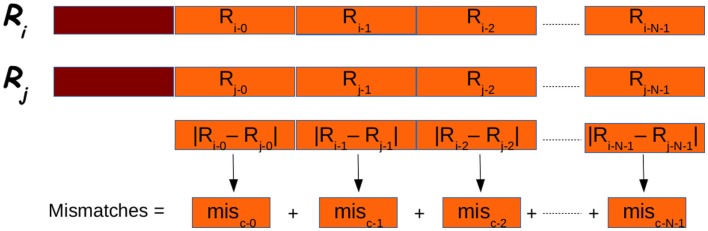
Suffixes (in orange in the figure) are analyzed in chunks. Each chunk is subject to the dual encoding used for prefixes (in red in the figure). The overall number of mismatches if obtained summing the partial number of mismatches obtained for each chunk.